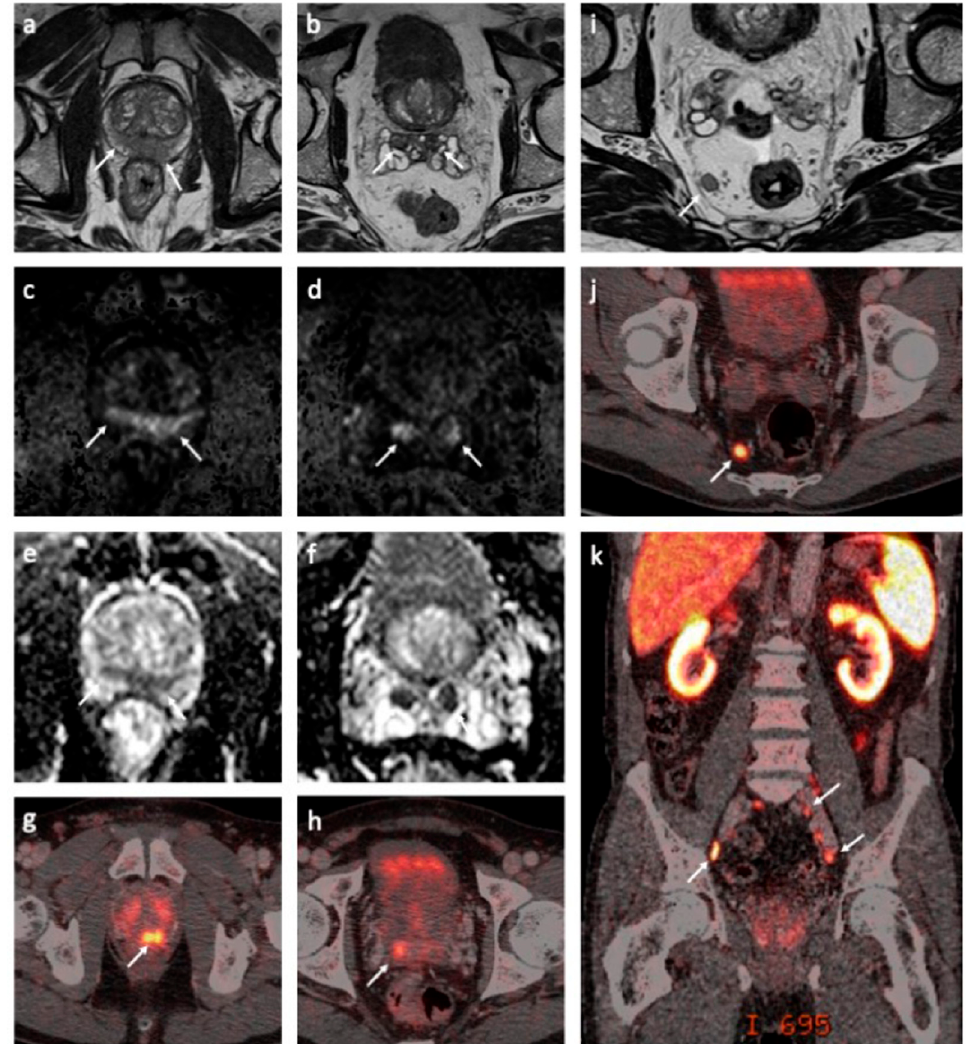
Figure 1. Magnetic resonance imaging (MRI) and prostate-specific membrane antigen (PSMA)- positron emission tomography (PET)/computed tomography (CT) findings at the baseline. Axial T2-weighted MRI sequences demonstrated a large, diffuse infiltrating tumor in the peripheral zone with seminal vesicle invasion ( a , b , white arrows). The tumor was hyperintense on diffusion- weighted MRI (DW-MRI) (b = 1500 s/mm 2 ) ( c , d , white arrows) with a corresponding low apparent diffusion coefficient (ADC) (ADC = 0.6 × 10 − 3 mm 2 /s) ( e , f , white arrows). Corresponding tracer uptake on fused PSMA-PET/CT images ( g , h , white arrow). A large lymph node metastasis in the mesorectal fat is shown on the axial T2-weighted MRI ( i , white arrow) and fused PSMA-PET/CT images ( j , white arrow). A coronal-fused PSMA-PET/CT image demonstrates multiple metastases to the pelvic lymph nodes ( k , white arrows).